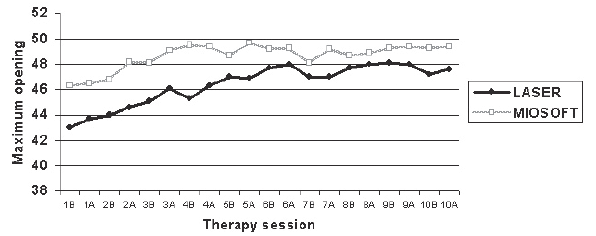
FIGURE 2- Mean maximum opening in millimeters for each group, before and after each therapy session